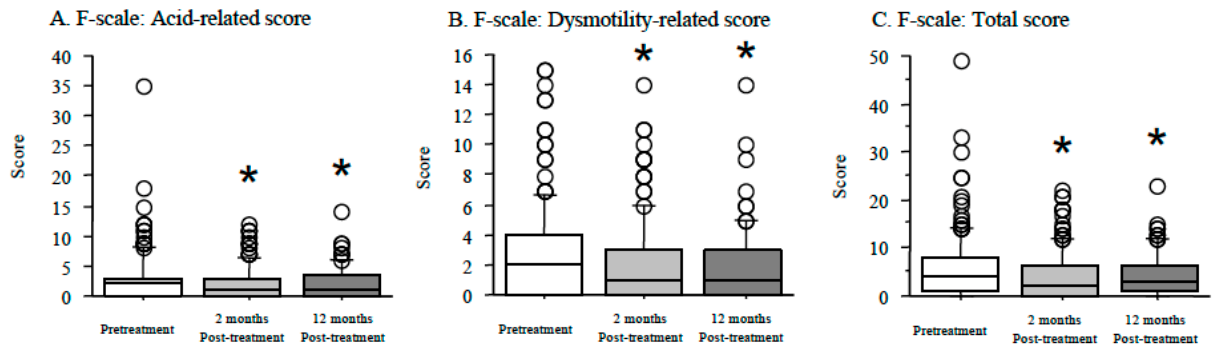
Figure 1. Association with the F scale ( A – C ) and time course at baseline, 2 months after treatment, and 12 months eradication success in 148 patients with successful H. pylori eradication evaluated in our hospital at 12 months after eradication success. Acid reflux, dysmotility-related, and total scores in the F-scale questionnaire were significantly decreased from scores at baseline. *: p < 0.05 vs. score at pretreatment.